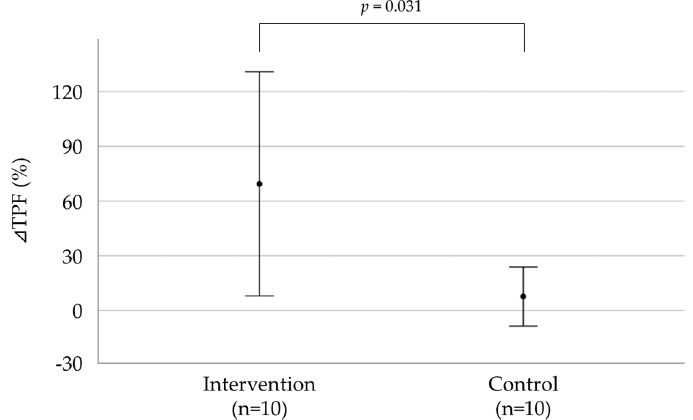
Figure 3. Comparison of the change in TPF after the exercise intervention program. ⊿ Represents the change in parameters. The Mann–Whitney U test was used for comparison between the two groups. Table 2. Comparison of the changes in clinical characteristics after the exercise intervention program.